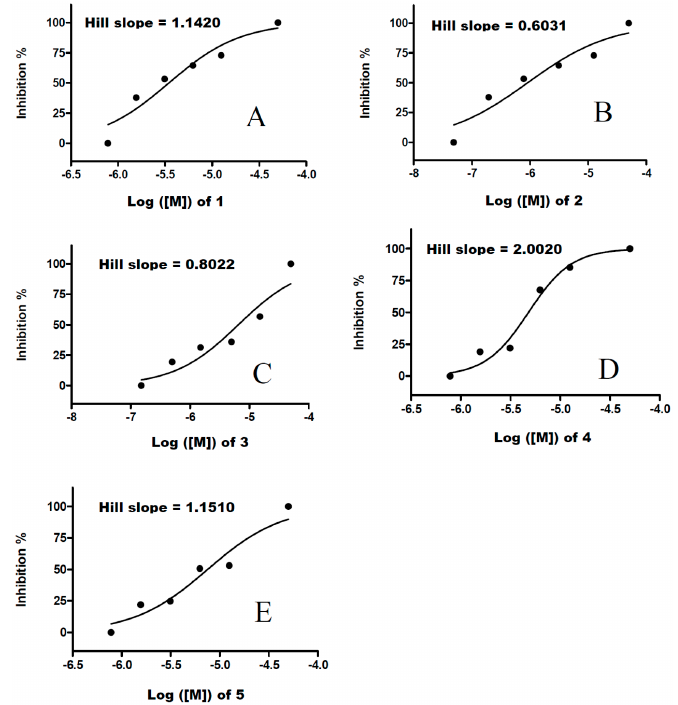
Figure 2. Dose response curves of compounds 1 ( A ); 2 ( B ); 3 ( C ); 4 ( D ) and 5 ( E ) tested against Pf TrxR.